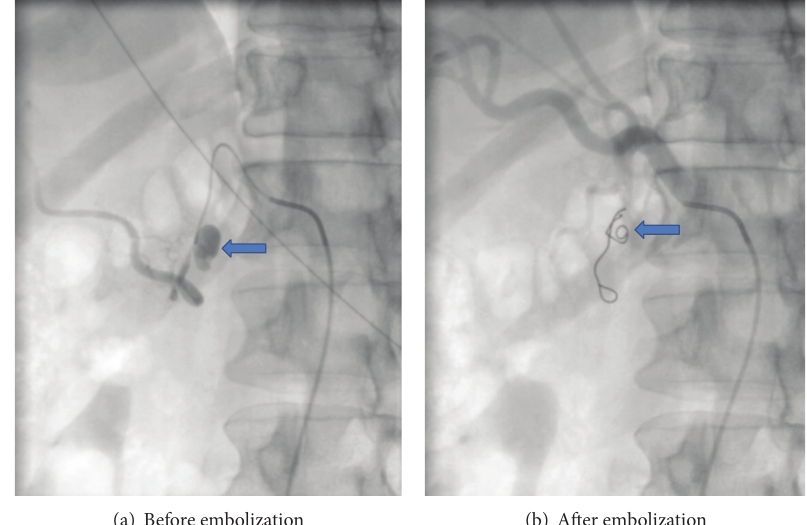
Figure 2: (a) Arrow pointing to pseudoaneurysm arising from branch of gastroduodenal artery. (b) Arrow pointing to platinum coil placed in gastroduodenal artery with successful exclusion of